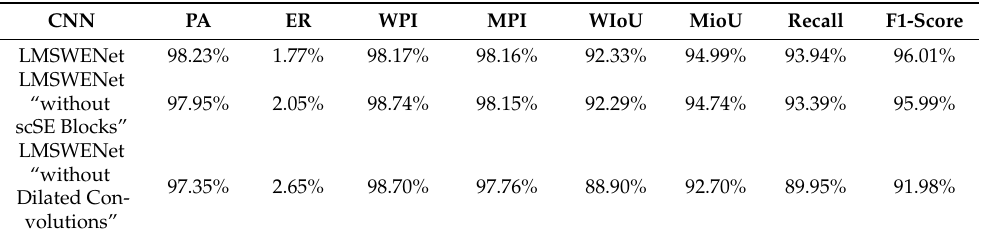
Table 8. Land surface water information extraction accuracy of LMSWENet, LMSWENet “without scSE Blocks” and LMSWENet “without Dilated Convolutions”.